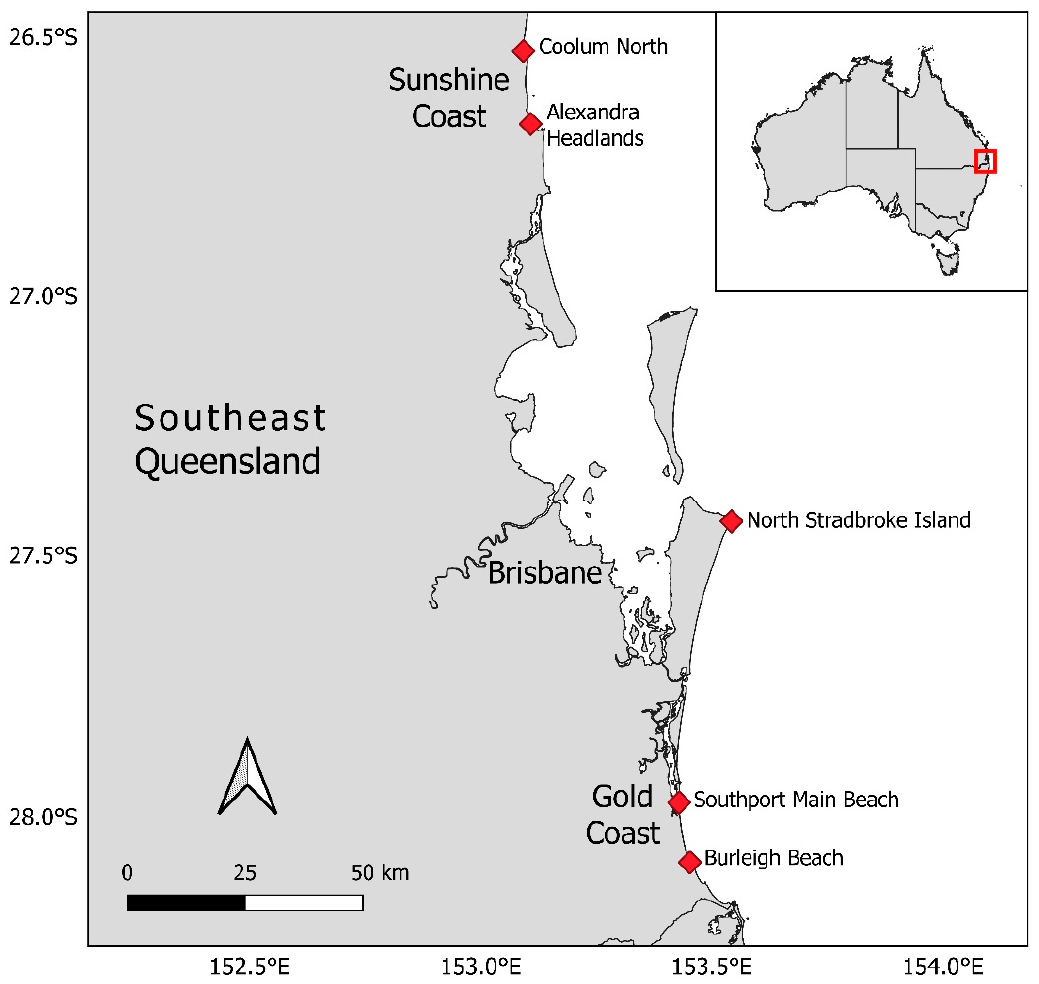
Figure 1. Map of Queensland SharkSmart Drone Trial beach locations in Southeast Queensland, Australia.